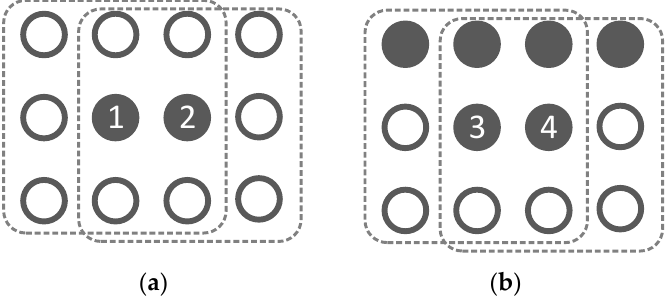
Figure 2. Two-dimensional diagram of sparse groups: ( a ) smooth region contaminated by noise and ( b ) edge region not contaminated by noise.